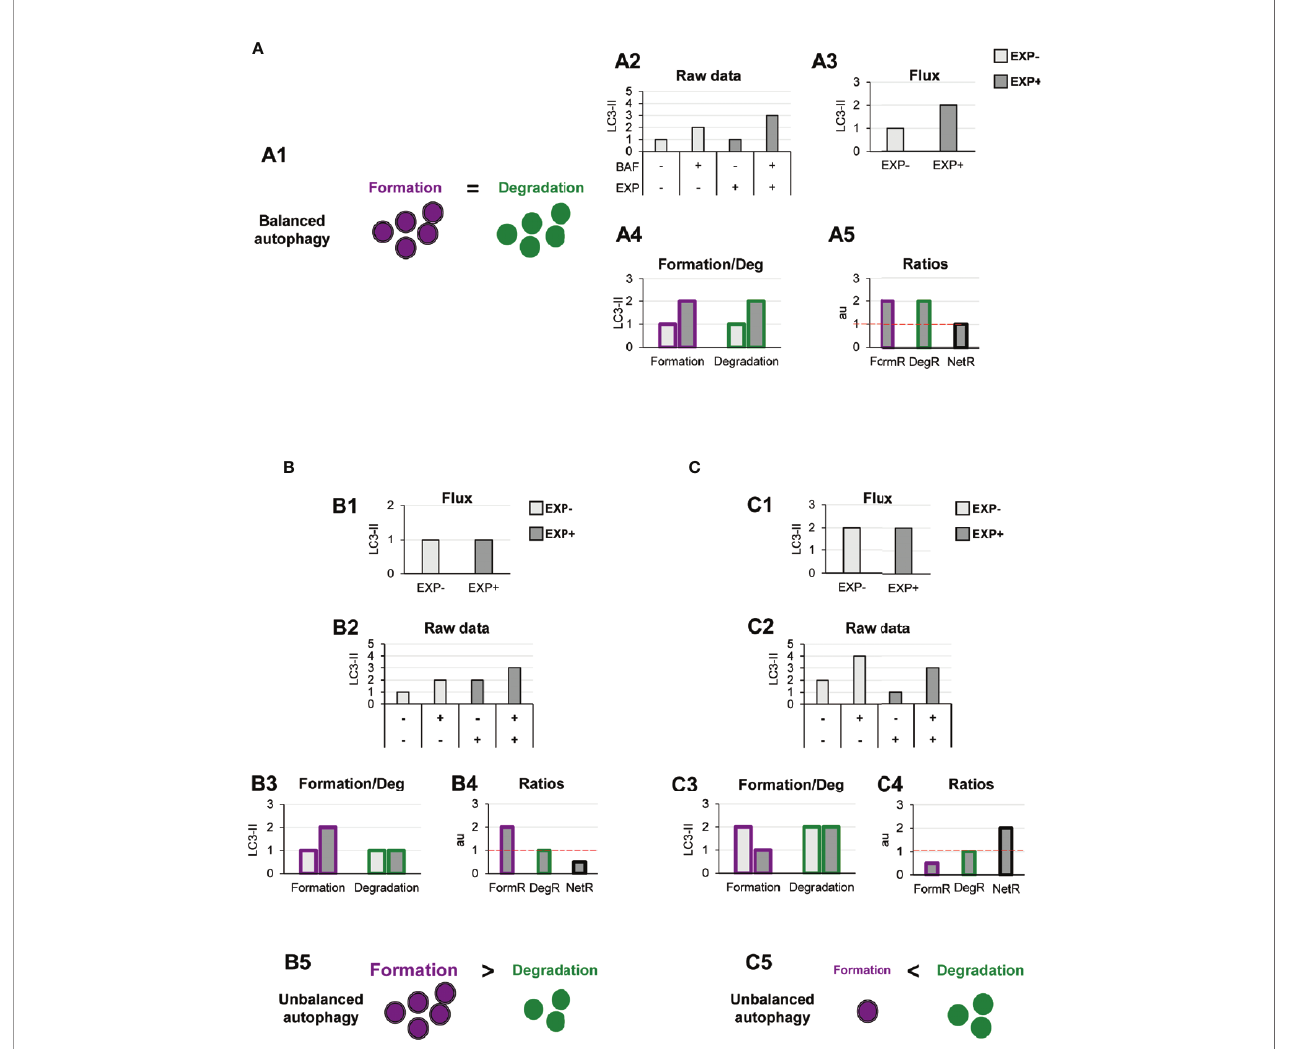
FIGURE 3 | Theoretical examples of variations in the formation of autophagosomes that lead to balanced or unbalanced autophagy. (A) Example of a balanced fl ux with proportional increase in autophagosome formation and degradation. The model of balanced fl ux with equal formation (purple dots) and degradation (green dots) (A1), the raw LC3-II/actin Western blot data (A2), the conventional autophagy fl ux (A3), the formation and degradation rates (A4), and the formation, degradation, and net ratios (A5) are shown. The red dotted line represents the threshold of one to determine a signi fi cant change (over 1, basal conditions) in the formation, degradation and net turnover ratios. (B , C) Show examples with similar conventional fl ux (B1, C1), which are in fact derived from dissimilar raw LC3-II/actin Western blot data (B2, C2). In (B) Our model would reveal increased autophagosome formation rate and no changes in degradation rate (B3), leading to an increased formation ratio and reduced net ratio (B4), and an unbalanced autophagy (B5). In contrast, in (C) our model would reveal decreased autophagosome formation rate and no changes in degradation rate (C3), leading to an increased formation ratio and reduced net ratio (C4), and an unbalanced autophagy